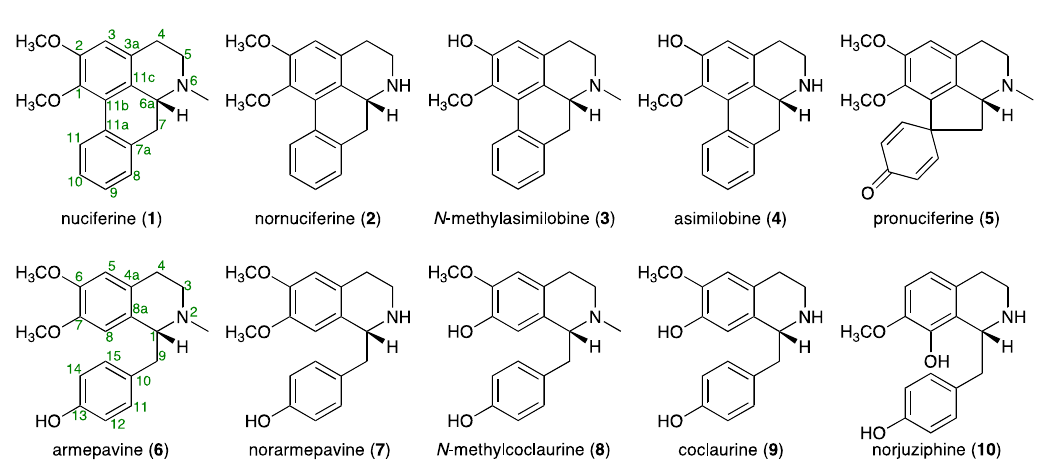
Figure 1. Aporphine and benzylisoquinoline alkaloids ( 1 – 10 ) from lotus flower.